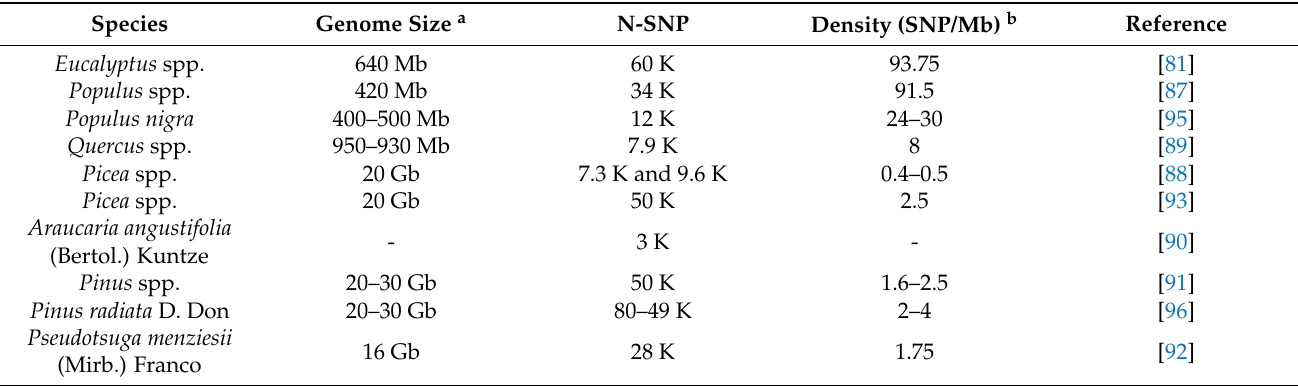
Table 1. Single nucleotide polymorphism (SNP) arrays developed for forest tree species. Genome size corresponds to the estimated genome size, N-SNP is the number of SNPs contained in each array. The density of markers is expressed as the number of SNPs per 1